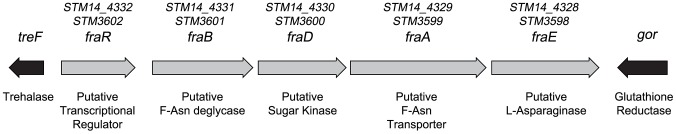
Map of the fra locus of Salmonella enterica.The five genes of the fra locus are shown as grey arrows. The gor and treF genes are shown as black arrows and are conserved throughout the Enterobacteriaceae while the fra locus is not, suggesting that the fra locus was horizontally acquired. The proposed functions and names of each gene are shown below and above the arrows, respectively. The names are based upon the distantly related frl locus of E. coli. For example, the deglycase enzyme of the frl locus is encoded by frlB so we have named the putative deglycase of the fra locus, fraB. The fra locus has no frlC homolog, while the frl locus does not have an asparaginase. Therefore, the name fraC was not used and the asparaginase was named fraE. The locus tags using the Salmonella nomenclature for strains 14028 (STM14 numbers) and LT2 (STM numbers) are shown above the gene names.